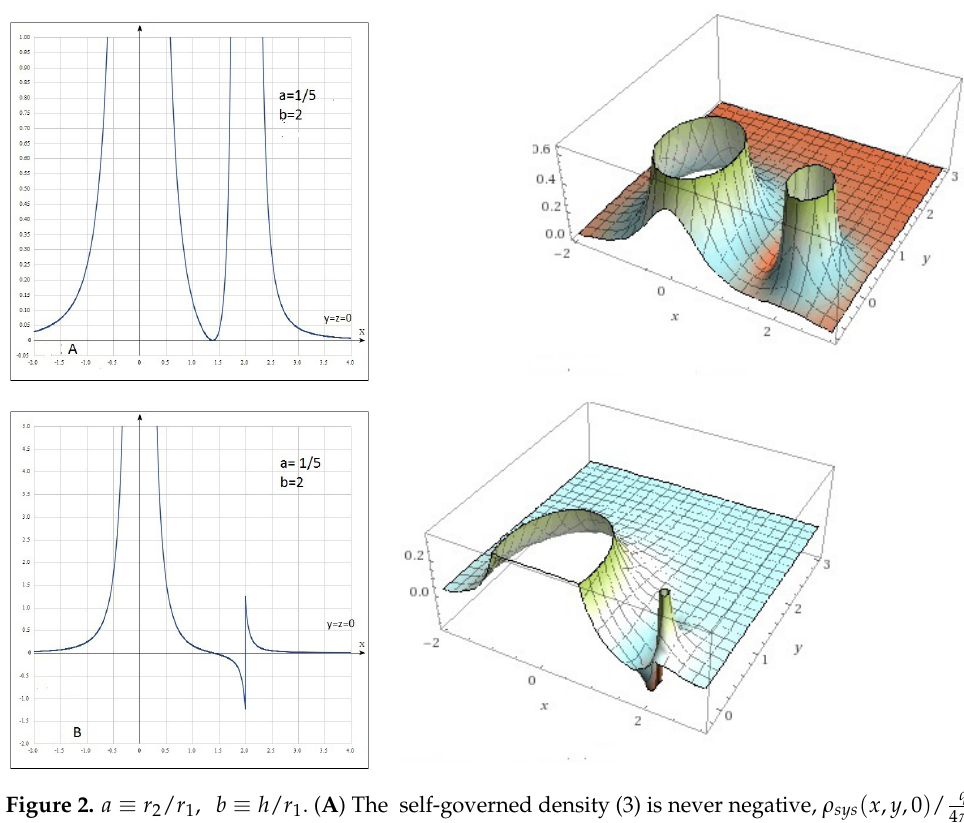
Figure 2. a ≡ r 2 / r 1 , b ≡ h / r 1 . ( A ) The self-governed density (3) is never negative, ρ sys ( x , y ,0 ) / q 1